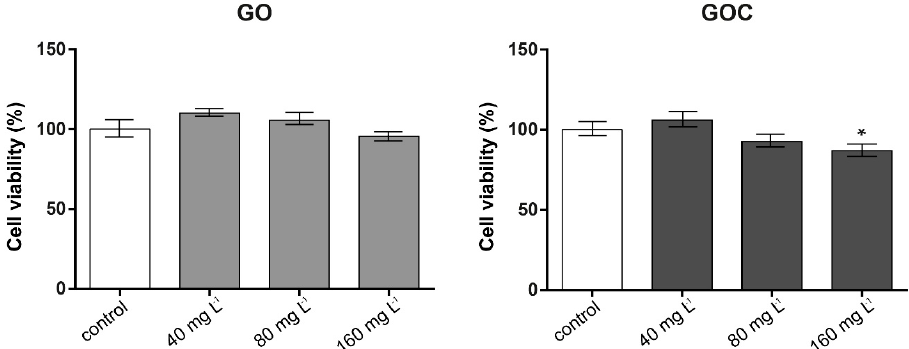
Figure 4. Viability of A549 cells (MTT assay) treated with di ff erent concentrations of GO ( left ) and GOC ( right ). Results are expressed as % of control (untreated cells). Data represent the mean ( ± standard deviation, SD) of three independent replicates. Di ff erences were established using a one-way ANOVA followed by Dunnett post hoc test to compare every mean with the control, and considered significant at p ≤ 0.05. * p ≤